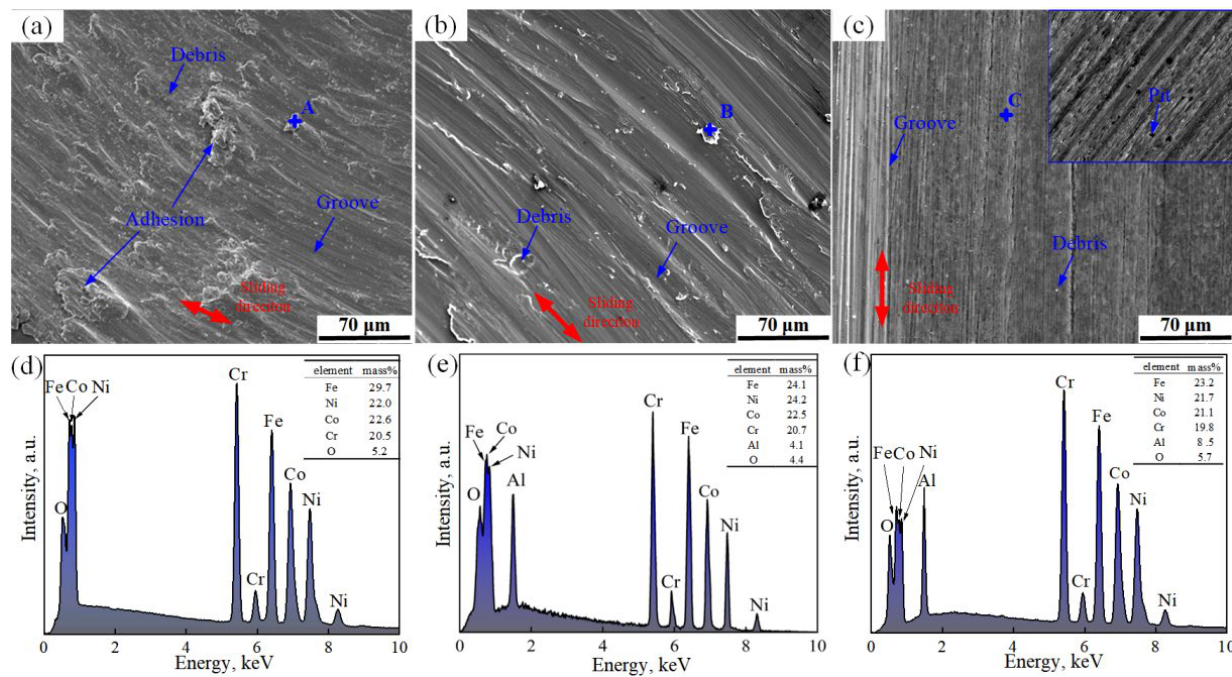
Figure 8. SEM images of worn surfaces and elements of the coatings of ( a , d ) FeCoCrNi, ( b , e ) FeCoCrNiAl 0.5 , ( c , f ) FeCoCrNiAl.